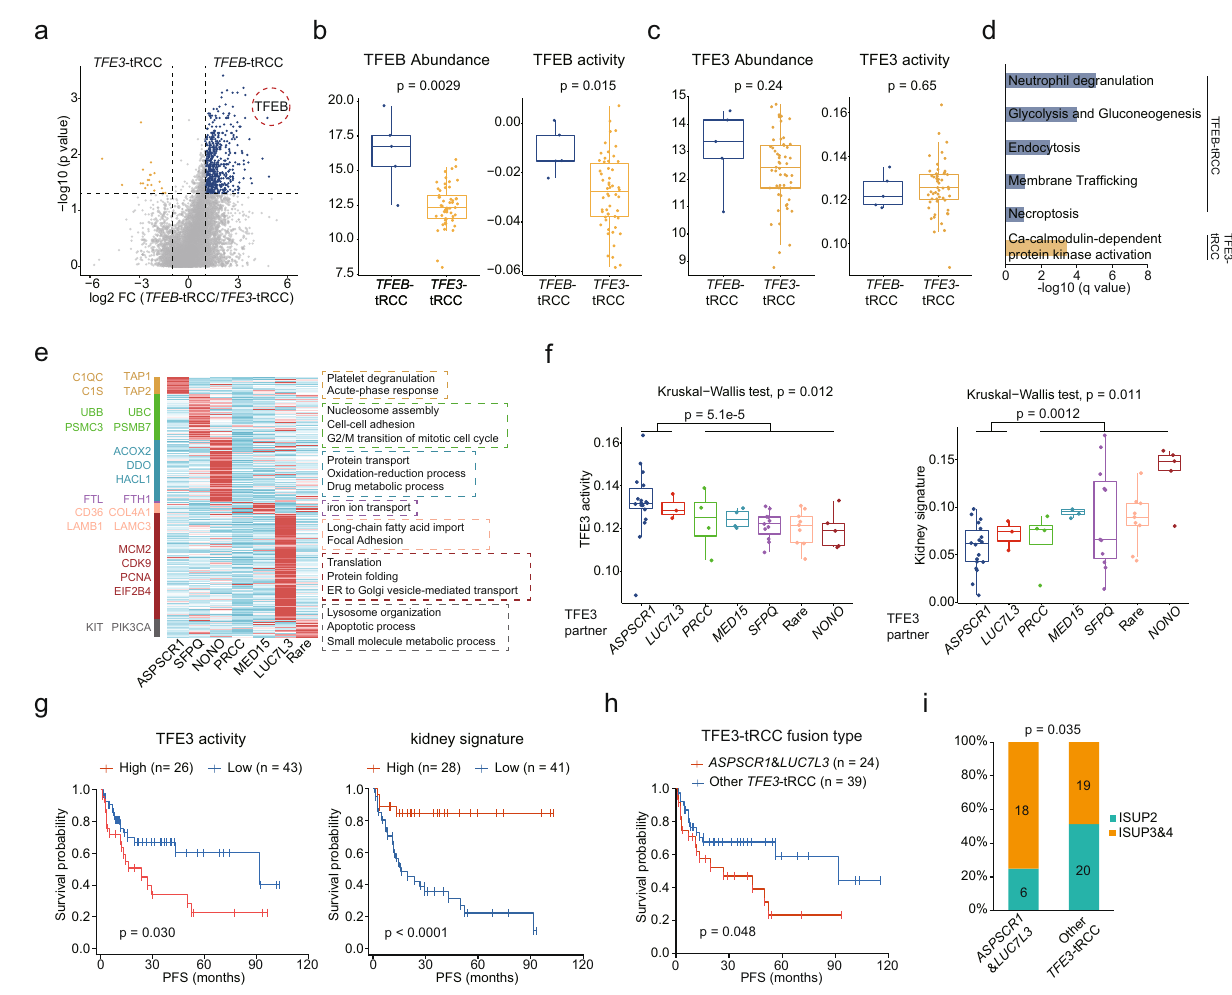
Fig.5|MolecularheterogeneityofdifferentfusiontypesoftRCC.a Volcanoplot showing DEPs (two-sided Wilcoxon rank-sum test, p value <0.05, FC>2) of TFEB - tRCC and TFE3 -tRCC tumors. b , c Comparisons of TFEB and TFE3 product levels and activities in TFEB -tRCC ( n =5) and TFE3 -tRCC ( n =54) tumors. d DEPs in TFEB - tRCC and TFE3 -tRCC tumors enriched biological pathways. e Elevated proteins in different TFE3 -tRCC fusion types and involved biological processes. f Comparison of TFE3 activities and kidney signature scores among different TFE3 -tRCC fusion types ( APSCR1 , n =18; LUC7L3 , n =3; PRCC , n =4, MED15 , n =4; SFPQ , n =11; Rare, n =9; NONO , n =5). P values are derived from two-sides Wilcoxon rank-sum test.